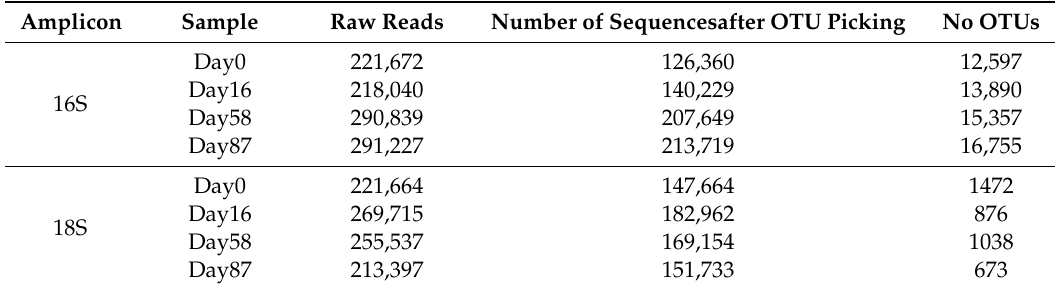
Table 2. Number of raw reads, sequences after operational taxonomic unit (OTU) picking and identified OTUs, for each timepoint, identified for 16S rRNA and 18S rRNA amplicon sequencing.